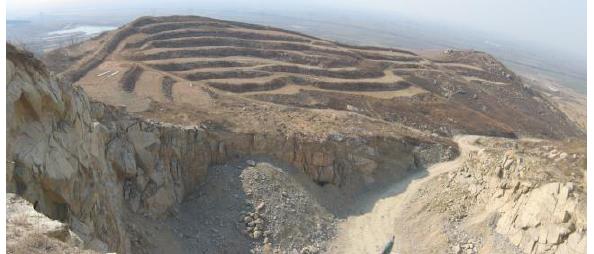
Figure 14. The relationship between the wall and digging hole in Kuo Mountain